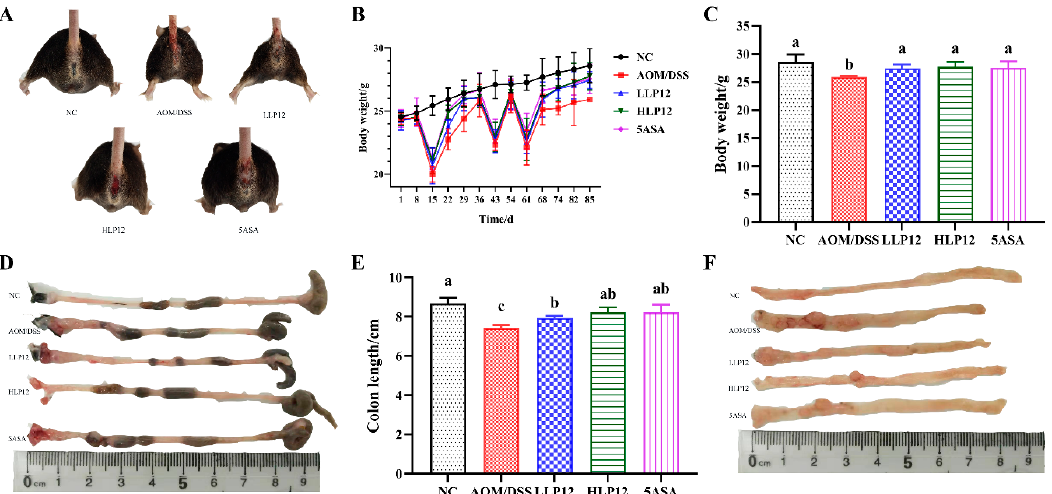
Figure 2. Effect of L. plantarum -12 oral administration on body weight and colon length of the AOM/DSS-treated C57BL/6 mice ( n = 6). ( A ) Mice morphology, ( B ) mice body weight, ( C ) mice body weight on the 85th day, ( D ) colon morphology, ( E ) colon length of the mice, and ( F ) mice terminal colon morphologies under different treatments. The data with different lowercase letters are signif- icantly different ( p < 0.05).